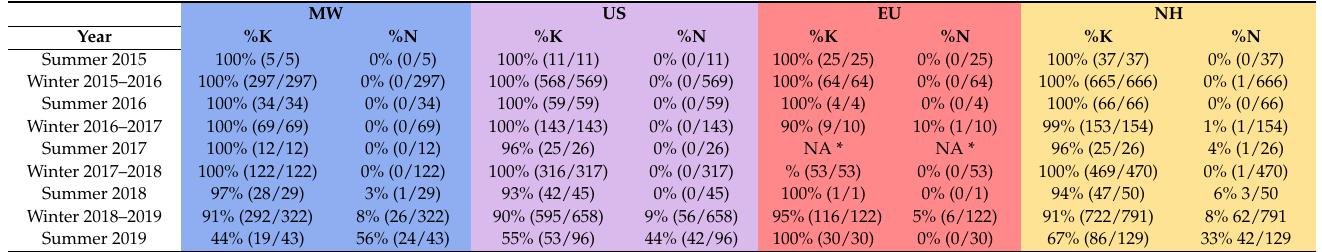
Table 3. Evolutionary timeline of hemagglutinin K147N variant by flu season and dataset, with the MW, US, EU, and NH datasets represented in blue, lavender, red, and yellow (respectively). MW US